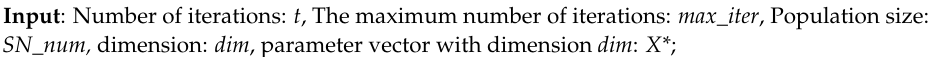
Algorithm 1: The steps of WOA optimization parameters.